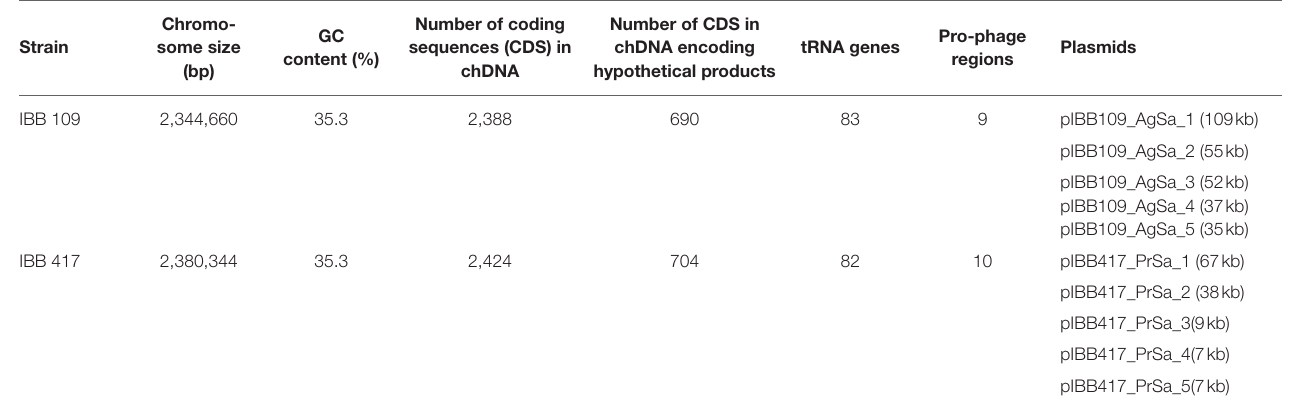
TABLE 3 | Main features and annotation data for L. lactis IBB109 and IBB417 genomes.